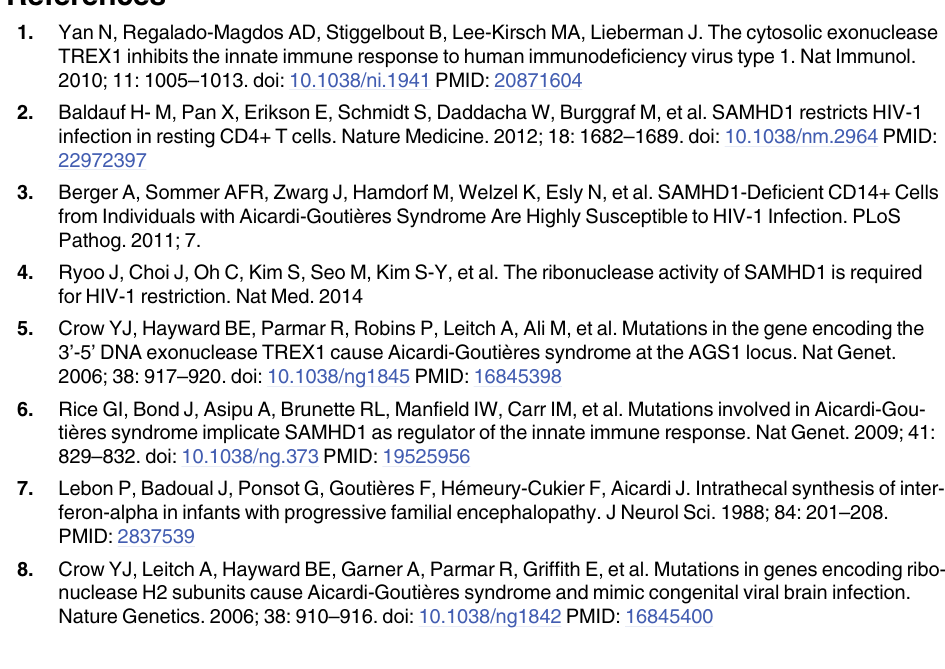
S1 Fig. Original ADAR1 Western